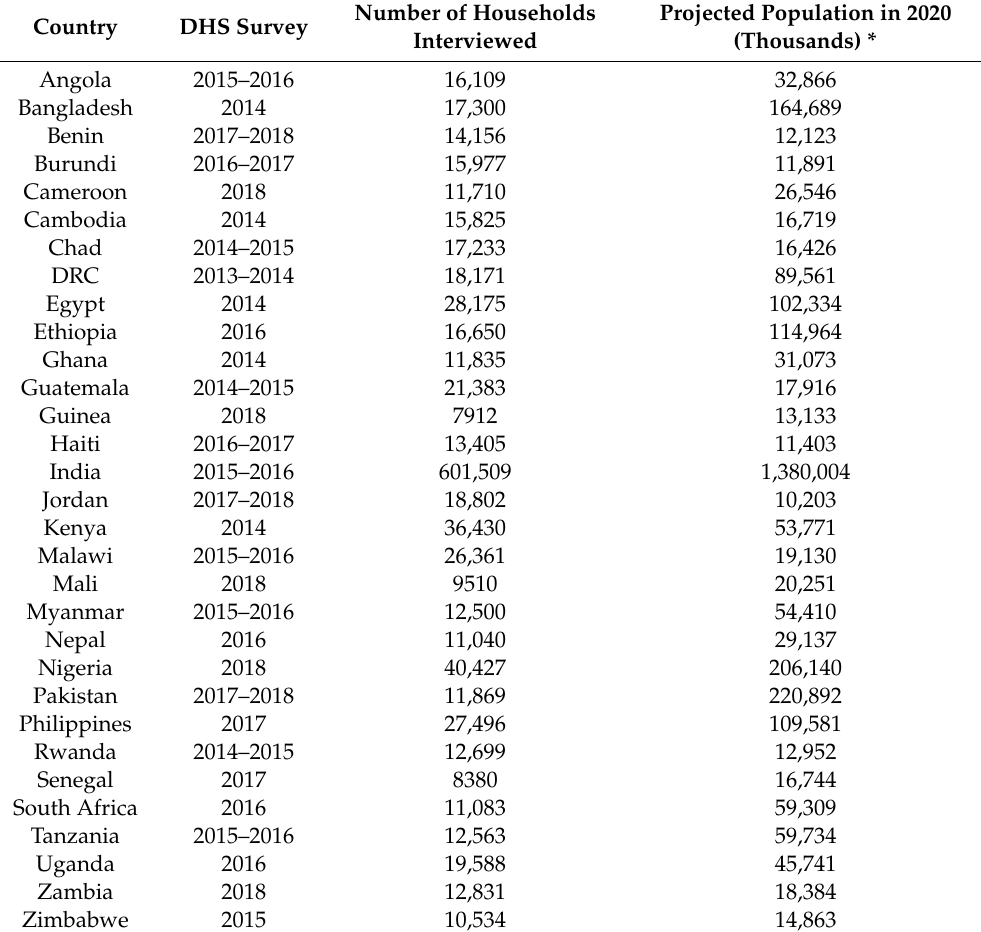
Table 1. Surveys used in the analysis with sample sizes and population